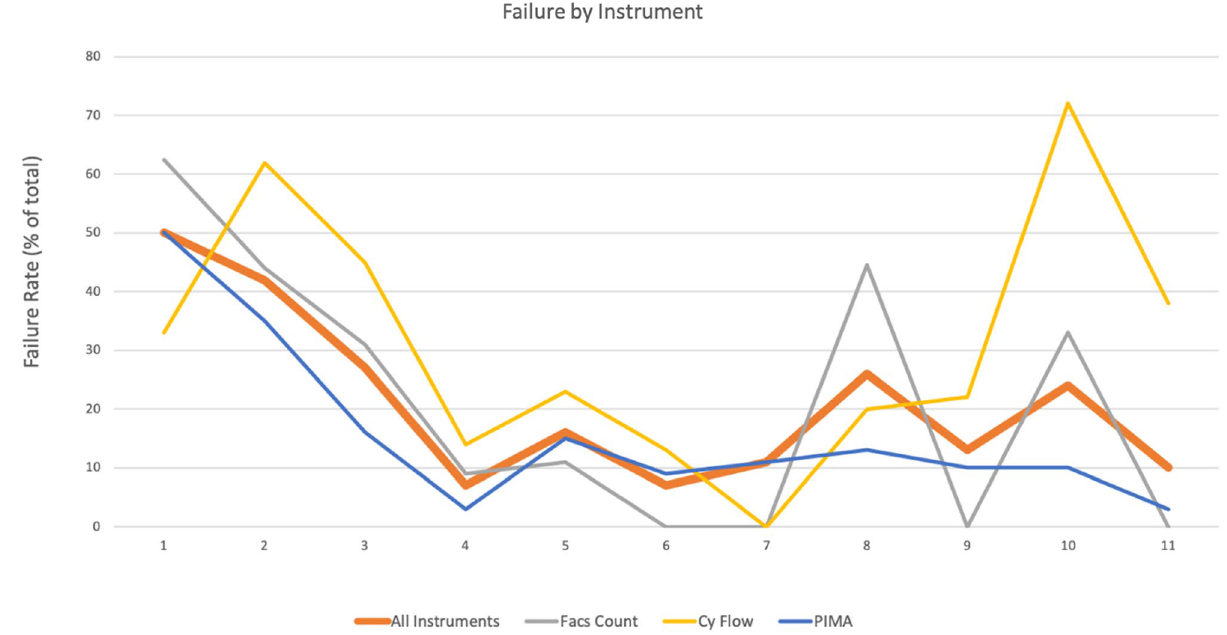
Figure 5. Failure Rates for 11 evaluated EAQ sessions broken down by type of instrument used. Failure rates as a percentage of the total are shown for all combined instruments, FACSCount instruments, CyFlow instruments and PIMA instruments. Data shown includes only participants who returned a result, not those who were unable to report a